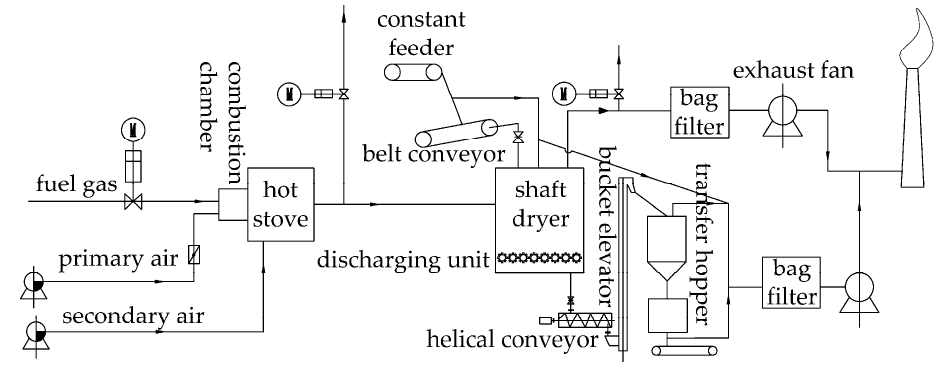
Figure 1. Scheme of the green coke drying system.